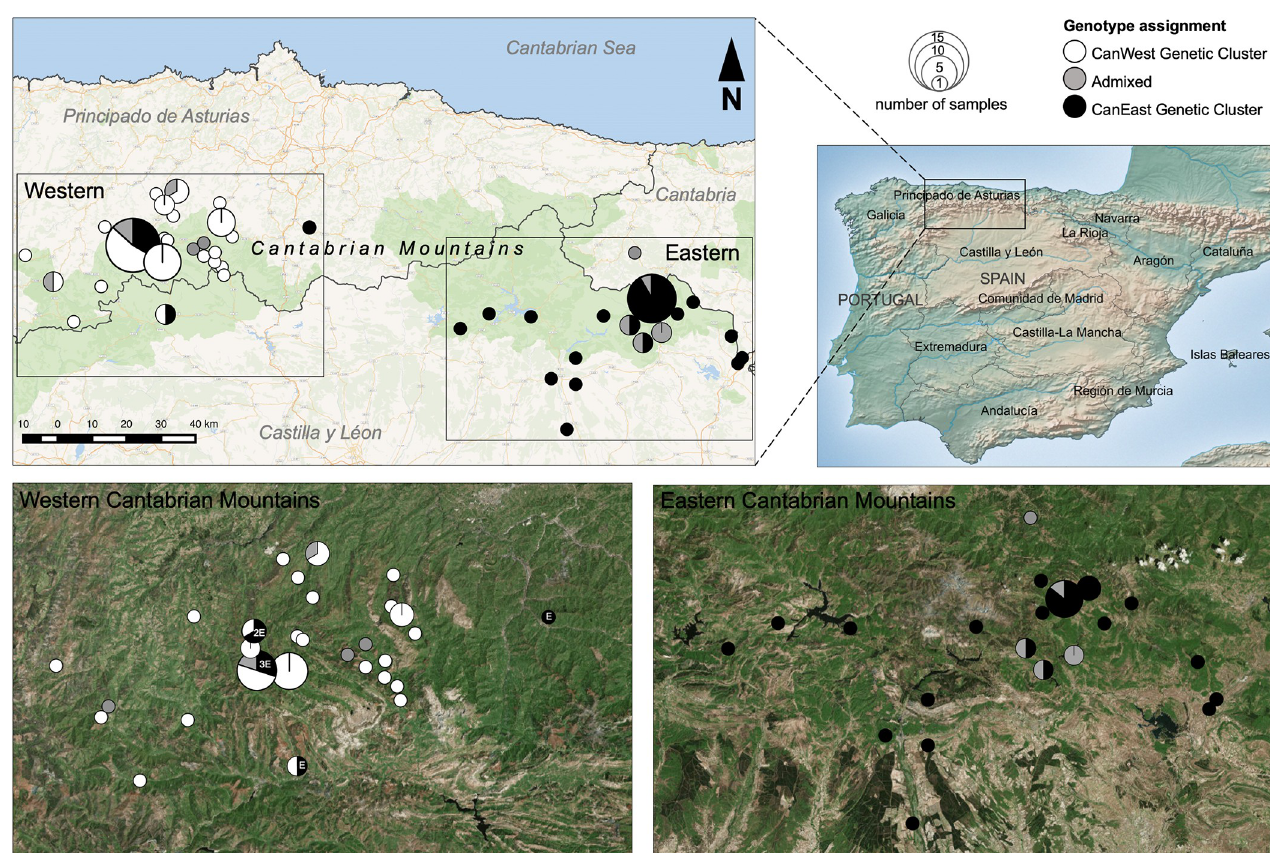
Fig 1. Map of the study area, with sampling locations for all genotyped individuals. Individuals are identified according to their assignment to genetic clusters or their admixed origin (based on STRUCTURE results and the thresholds inferred in HYBRIDLABS): CanWest (white); CanEast (black); admixed (grey). All individuals sampled from the Eastern Cantabrian population present the CanE haplotype and all individuals sampled from the Western Cantabrian population present the CanW haplotype, apart from seven individuals denoted “E”. Maps modified from: Natural Earth (naturalearthdata.com) physical map (top right); satellite images from Copernicus Sentinel Data (2017) for Sentinel-2A/B, obtained from the Copernicus open access hub (bottom); data from OpenStreetMap contributors, through Wikimedia Commons QGIS unlabelled layer (top left).